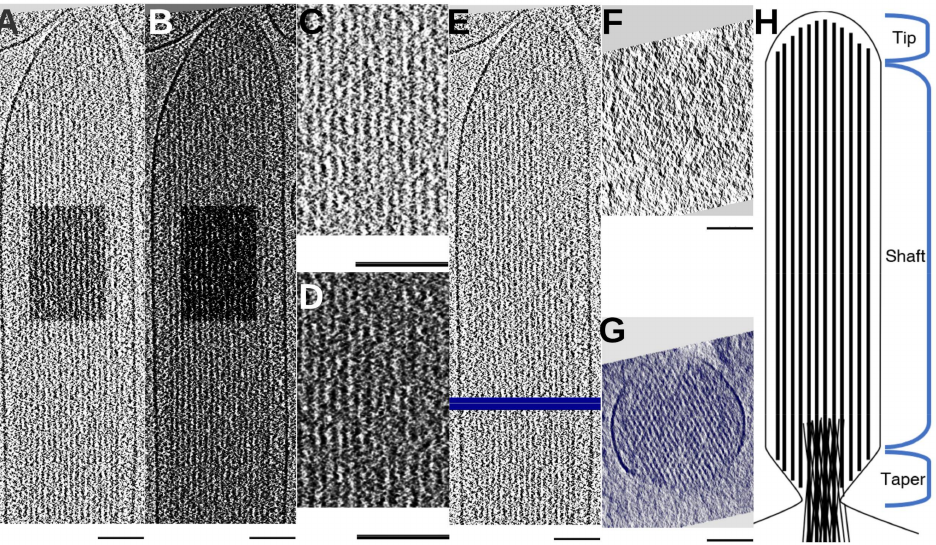
Figure 1. Cryo-ET density map for the shaft of a stereocilium and its membrane-enclosed actin bundle. The longitudinal view of a stereocilium is shown for a slab about 1 nm thick in ( A ) and about 8 nm thick in ( B ). ( C , D ) are sub-regions (box) of ( A , B ), respectively. ( E ) shows the location of cross-section slices of ( F ) (white line) and ( G ) (blue line) respectively. Cross-sections about 1 nm thick and 30 nm thick are shown in ( F , G ), respectively. ( H ) shows the schematic of a stereocilium. All scale bars are 100